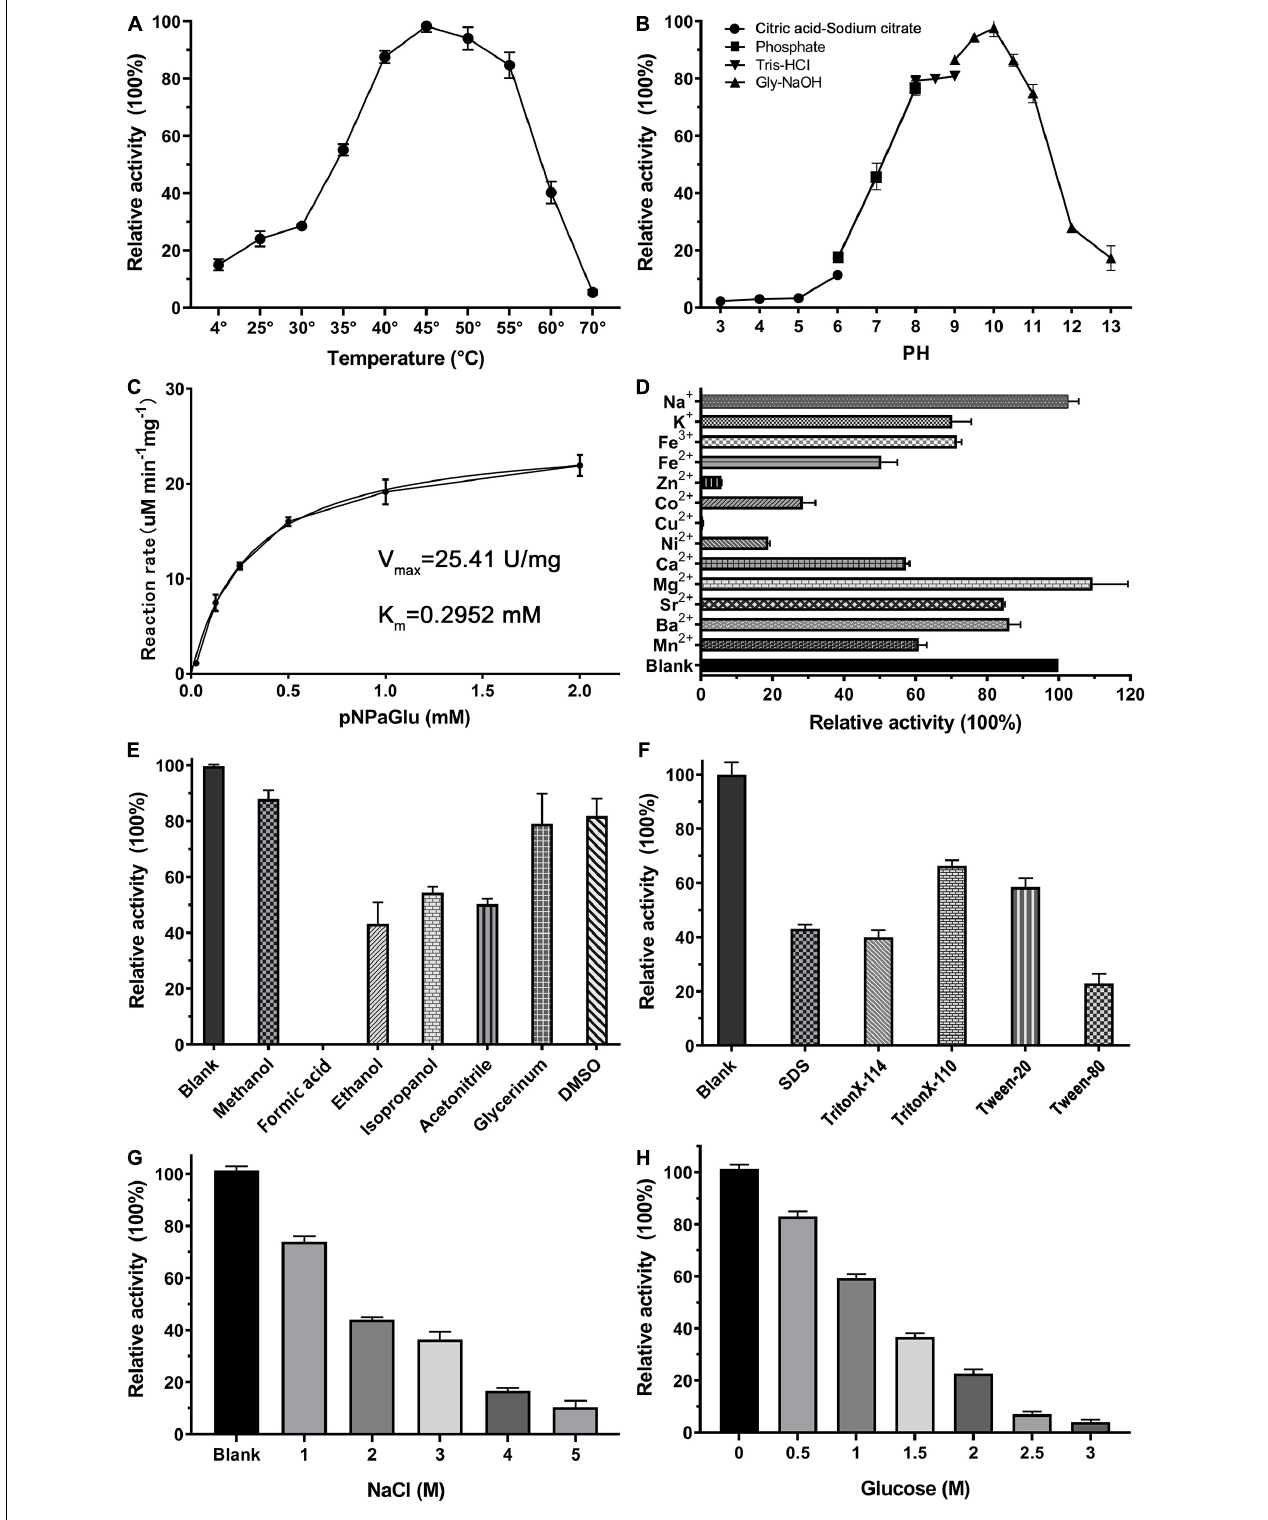
FIGURE 2 | Biochemical characterization of QsGH13. (A,B) The effect of temperature and pH on enzyme activity of QsGH13. The value obtained at 45 ◦ C and pH 10.0 was taken as 100%, respectively. (C) The specific activity of QsGH13. (D–H) Effects of different metal ions (10 mM), detergents [10% (v/v)], organic solvents [10% (v/v)], NaCl concentration, and glucose concentration on the enzymatic activity. The values of blank control were taken as 100%.